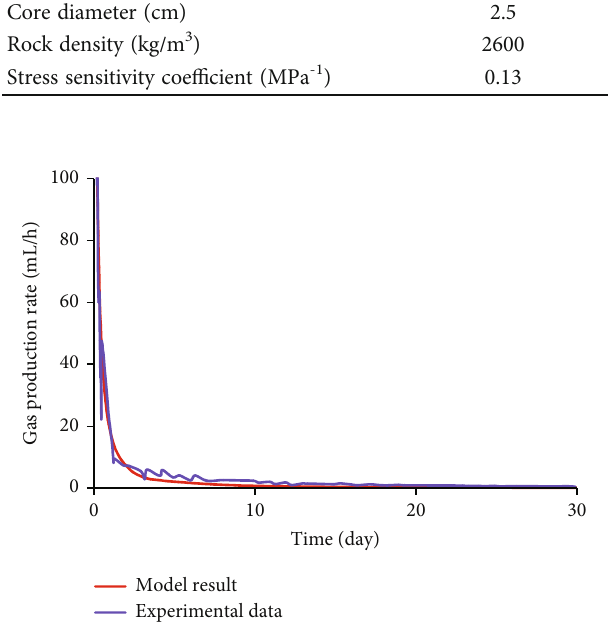
Figure 12: Fitting results of gas production rate of tandem cores.